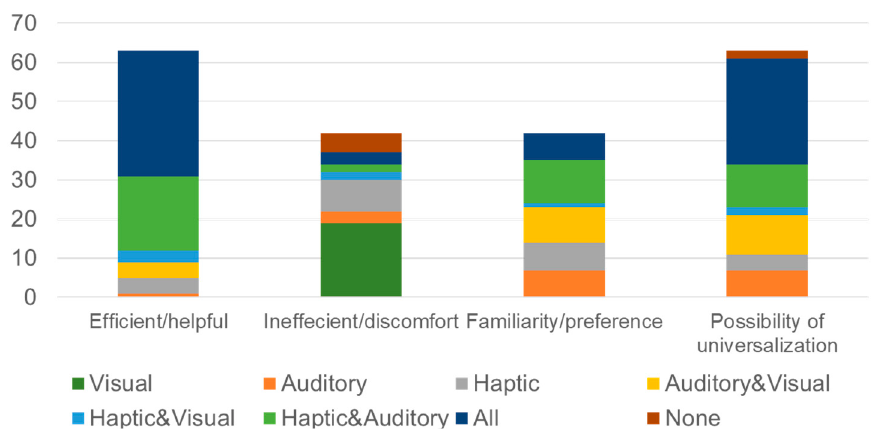
Figure 12. Short answer questionnaire evaluation results.